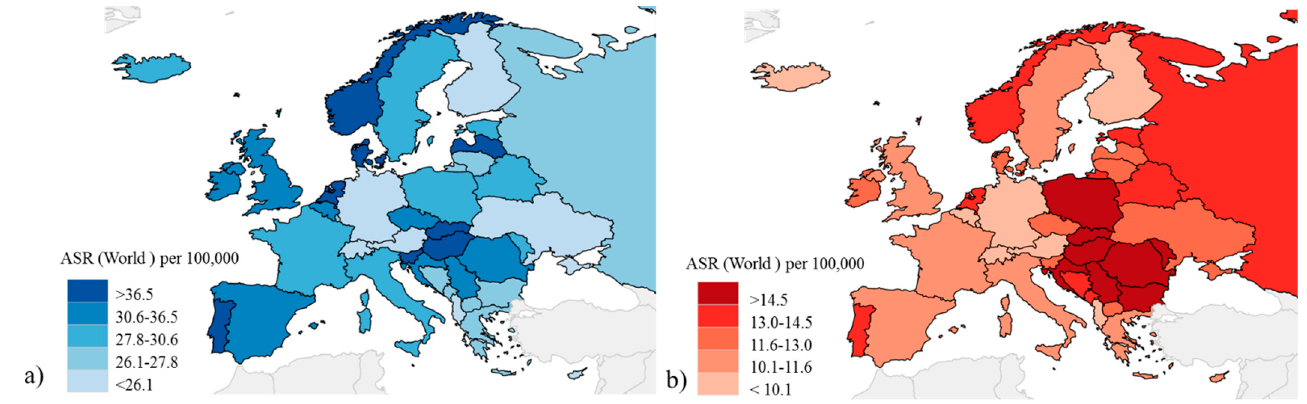
Figure 2. Colorectal cancer in Europe in 2020. ( a ) Estimated age standardized incidence rate (100,000) for European countries; ( b ) Estimated age standardized mortality rate (100,000) for the European countries. Modified from Global Cancer Observatory 2020, International Agency for Research on Cancer, World Health Organization [6].